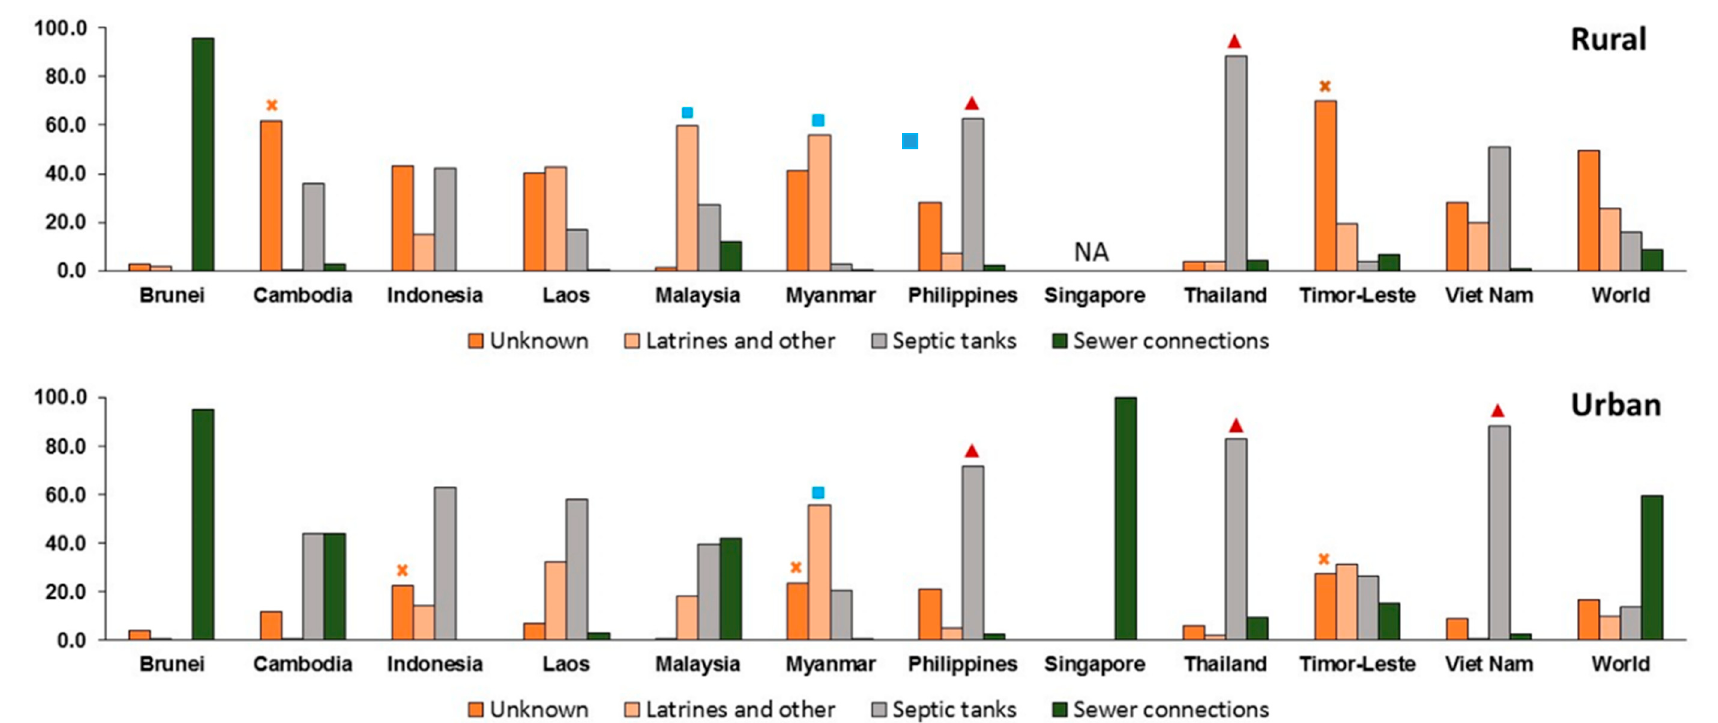
Figure 6. Percentages of the rural and urban population serviced by improved latrines or similar, septic tanks or have sewer connections in eleven countries in SE Asia in 2017 [12]. Unknown implies inadequate data to clearly define.